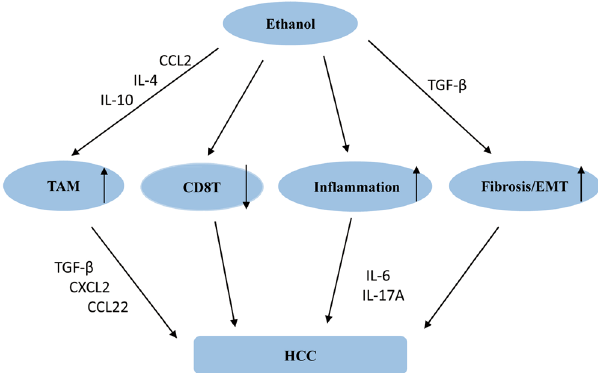
Figure 6. Multifactorial effects of ethanol promotion on DEN-initiated hepatocellular carcinoma. Alcohol consumption accelerated DEN-initiated HCC via many aspects. Firstly, alcohol consumption increased hepatic IL-4, IL-10, CCL2 expression, which in turn recruited monocytes into liver and polarization into M2- phenotype. Increased hepatic TGF- β , CXCL2, CXCL22 expression promoted HCC progression. Secondly, alcohol consumption reduced CD8 + T cells in the liver, which exhibited antitumor activity in existing study. Besides, alcohol consumption leaded a higher inflammation response in the liver, including increasing IL-6, IL-17A, which displayed a promotion on HCC progression. Moreover, increased hepatic TGF- β expression after alcohol consumption facilitated fibrosis and EMT progress, which were associated with HCC